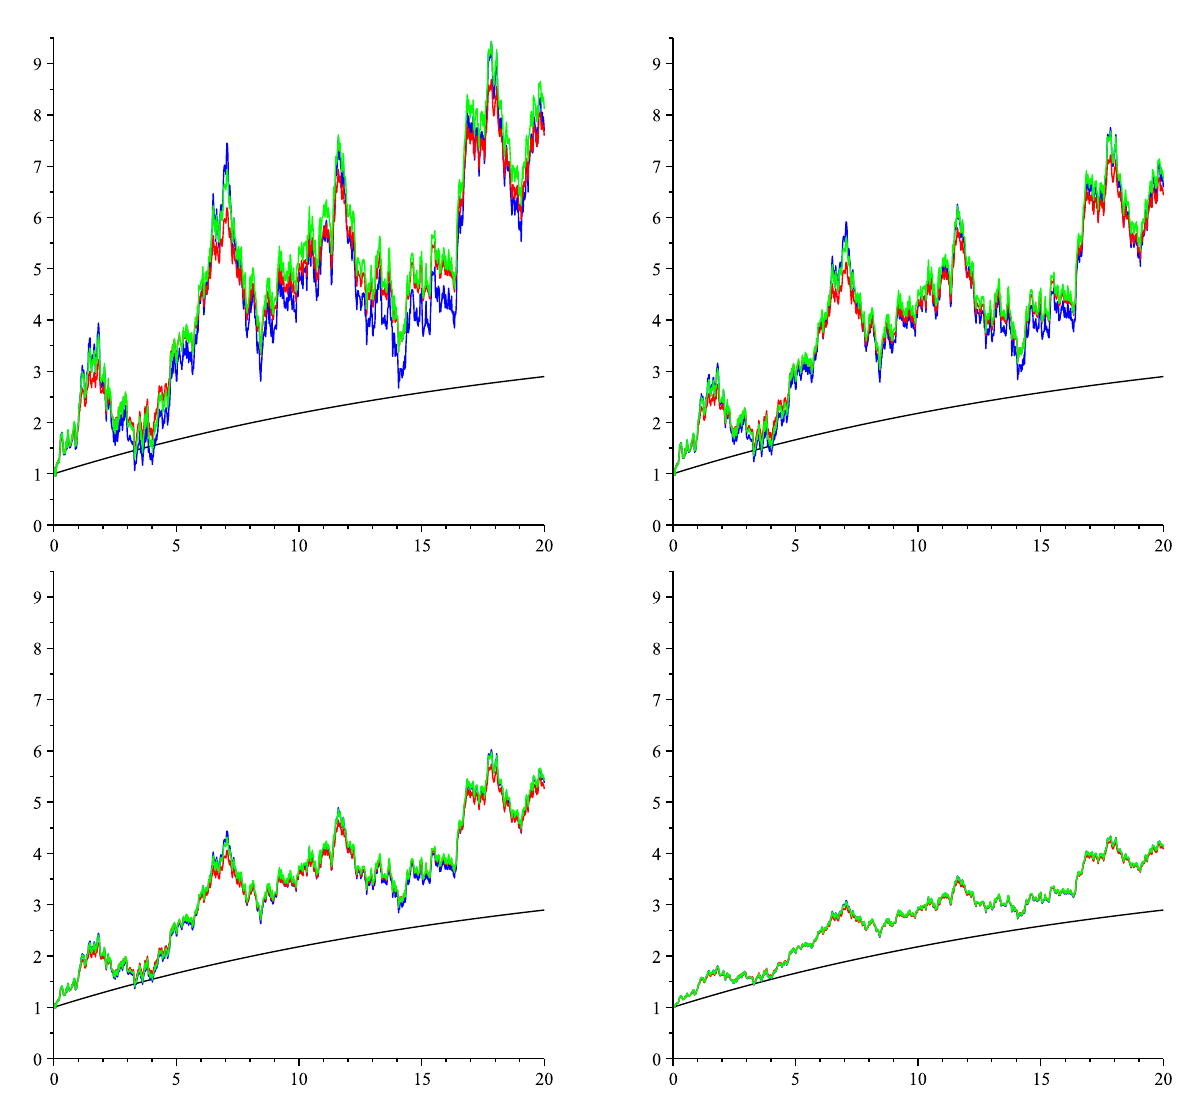
Figure 2. Expectation function E [ X ( t )] (black) and simulated paths of X ( t ) (green), b X ( t ) (blue) for & = 1 ( top left ), & = 0 : 75 ( top right ), & = 0 : 5 ( bottom left ), (red) and & = 0 : 25 ( bottom right